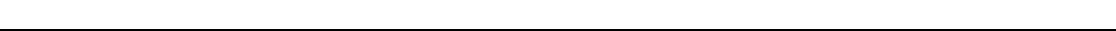
Fig. 6 AMPA-mediated currents evoked by neuron activity drive AP fi ring in pre-OLs. a Representative trace of synaptic currents evoked by glutamate application (1 mM) in an excitable pre-OL during voltage-clamp recording (P10). CNQX (50 µ M; AMPAR blocker) largely reduced the synaptic current; additional application of Naspm (50 µ m; Ca 2+ -permeable AMPAR blocker) abolished most of the remaining current. b Summary of glutamate receptor- mediated synaptic currents in the presence of CNQX and Naspm. c Representative trace of glutamate-evoked depolarization and fi ring in an excitable pre- OL in a current-clamp recording. Application of CNQX blocked nearly all depolarization and subsequent spikes. Inset , expanded time scales of APs. d Summary of membrane potential changes upon glutamate application in the presence of CNQX and Naspm. Data represent the mean ± s.e.m.; * P < 0.05, *** P < 0.0001. e Immunostaining of CNPase-eGFP+ cells with antibodies against calretinin (Ca 2+ -bind protein as a marker for axon fi bers, red ) and Na v 1.2 ( blue ) in the MNTB (P14). Note that processes of CNPase-eGFP+ cells make contact with axon fi bers. Scale bar , 10 μ m. f Glutamate-mediated synaptic currents evoked by axon fi ber stimulation (100 Hz, 1 s; see diagram ) in an excitable pre-OL (P11). CNQX blocked the synaptic current. g Depolarization and fi ring activity evoked by electrical stimulation (100 pulses at 100 Hz) in a current-clamp recording of an excitable pre-OL. Inset, expanded time scales of an AP indicated in the box. Application of μ -conotoxin KIIIA (1 μ M) completely blocked fi ring activity, and additional application of CNQX (50 μ M) signi fi cantly reduced depolarization. Dashed lines indicate membrane potential. Red arrows indicate the end time point of the afferent fi ber